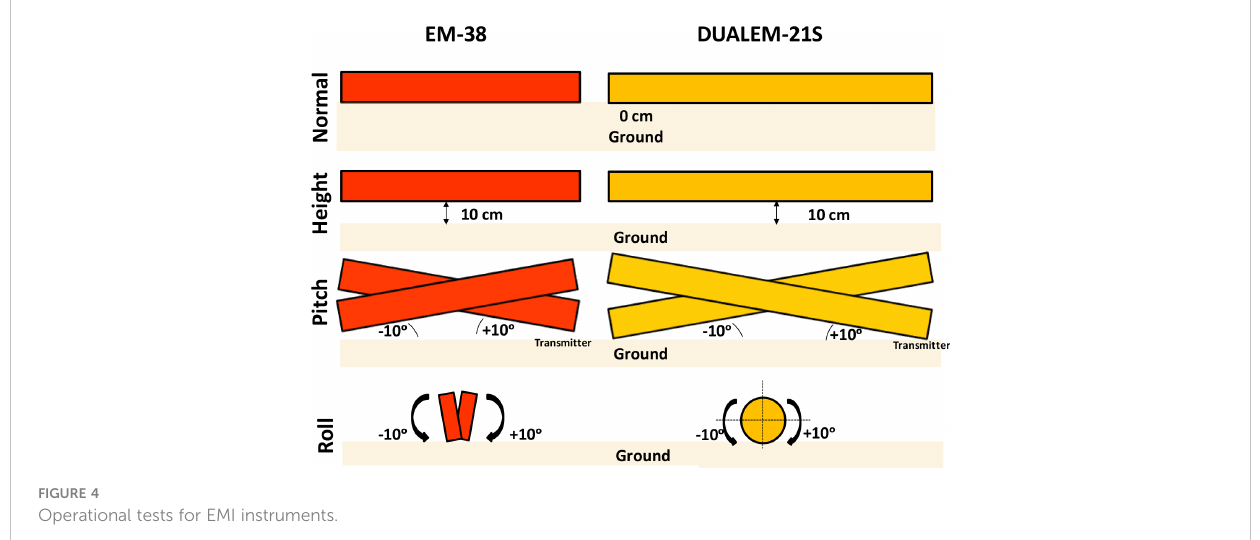
FIGURE 4 Operational tests for EMI instruments.